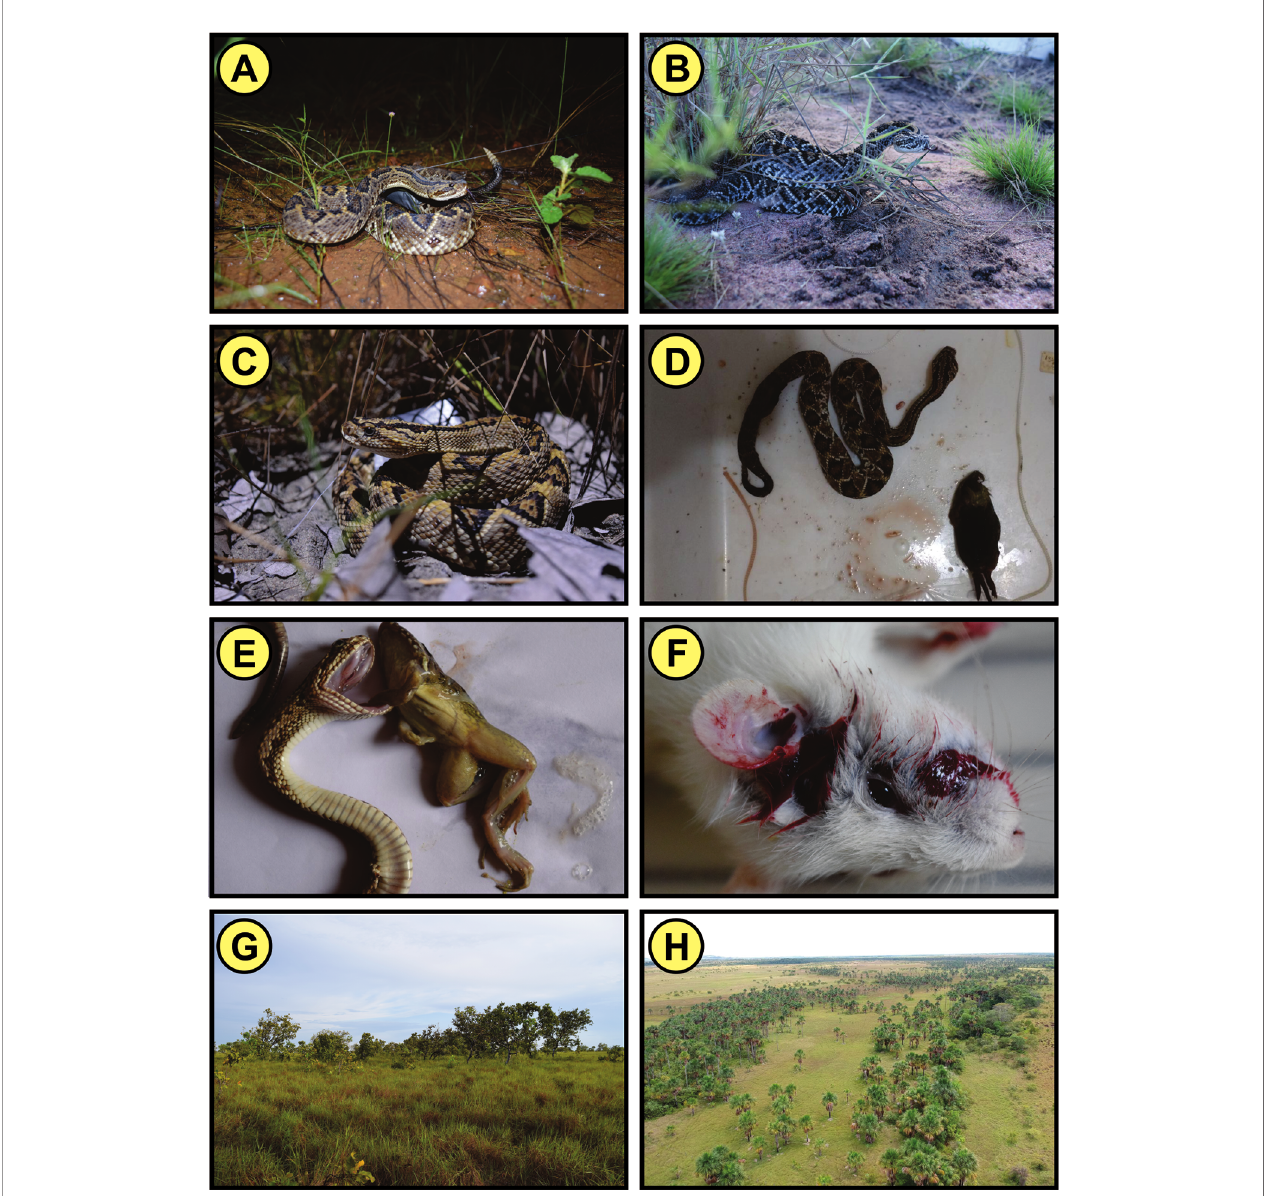
FIGURE 2 | (A – C) Crotalus durissus ruruima ; (D) Specimen of C. d. ruruima with rodent found in its stomach contents; (E) Amphibian Leptodactylus macrosternum regurgitated by a juvenile specimen of C. d. ruruima ; (F) Mouse recently bitten by a captive C. d. ruruima showing massive bleeding; (G) Region of savanna ( lavrado ) where C. d. ruruima occurs; (H) Aerial image of the savanna ( lavrado ) area where C. d. ruruima occurs. Pictures: Anderson Maciel